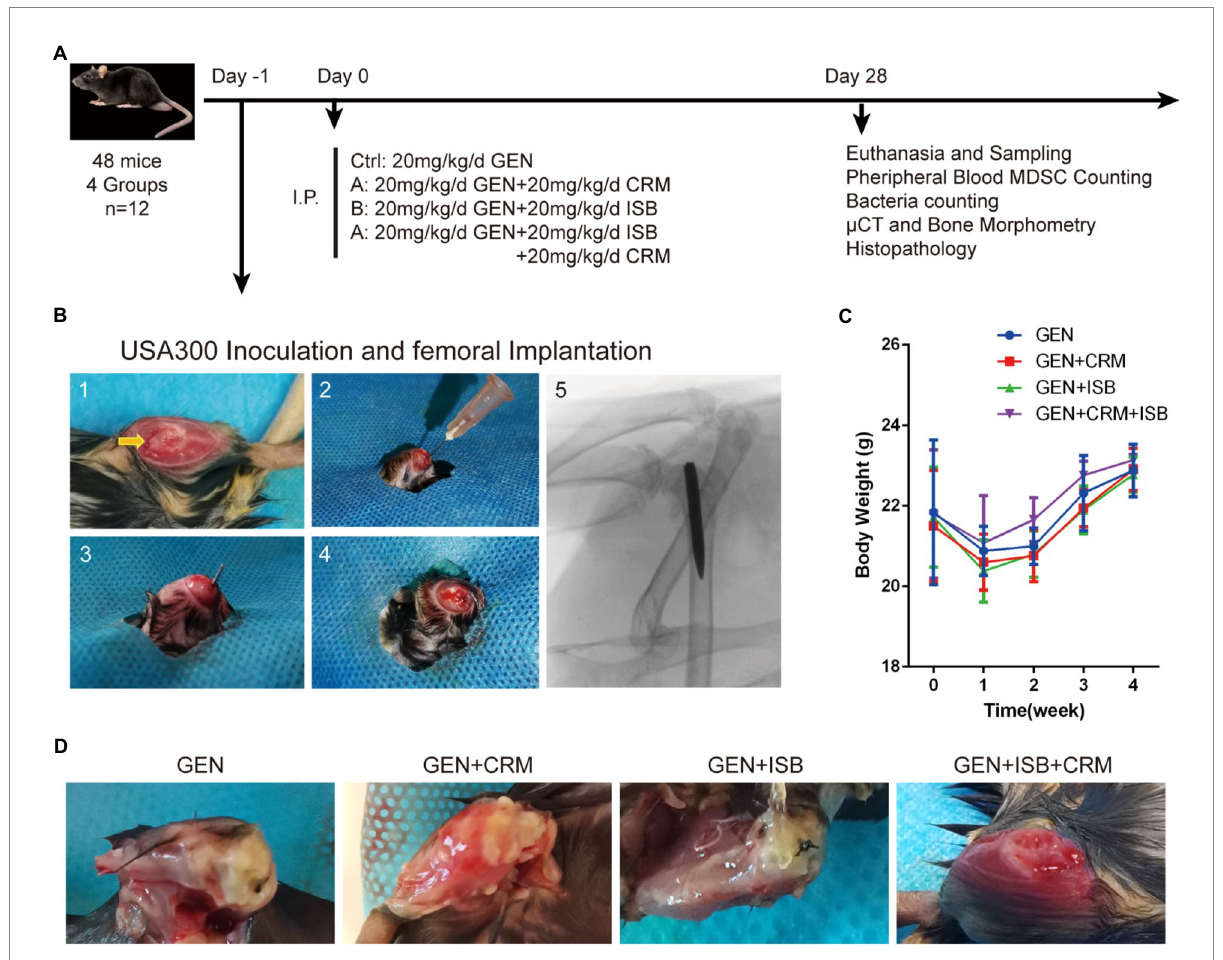
FIGURE 1 Orthopedic implant-related infection animal model of cocktail of isobavachalcone and curcumin with gentamycin against MRSA. (A) In vivo study design. (B) Surgical procedures of distal femoral implant-related infection mouse model. 1–5 refer to: (1) Distal femoral implant using a trans-knee approach, after incise internally alongside patella and externally dislocating patella to expose the distal femoral articular surface, and the entry point, intercondylar notch, was shown by the yellow arrow. (2) 25-gauge needle was used to open a corridor into the femoral medullary canal. (3) The customized 0.6 mm diameter needle was implanted after the inoculation of 5 μ l MRSA USA300 inoculum suspension. (4) The caudal end of the implant was left about 1 mm outside the femur after implantation. (5) The representative X-ray image of implant well positioned in the medullary canal and distal femur. (C) Body weight of animals throughout in vivo experiment. (D) Representative appearance of distal femurs of mice 28 days after intraperitoneal administration of different groups of antimicrobials combinations, gentamicin served as control. I.P., intraperitoneal injection; GEN, Gentamycin; ISB, Isobavachalcone; CRM,